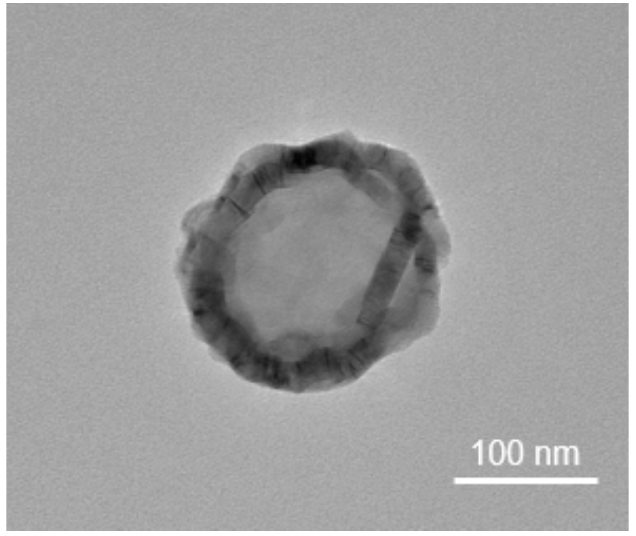
Figure 2. Transmission electron microscopy (TEM) image of MSC-derived EV morphology.